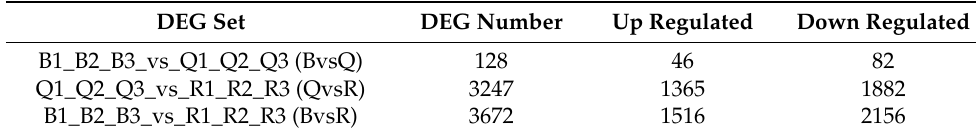
Table 2. Statistics of differentially expressed genes.